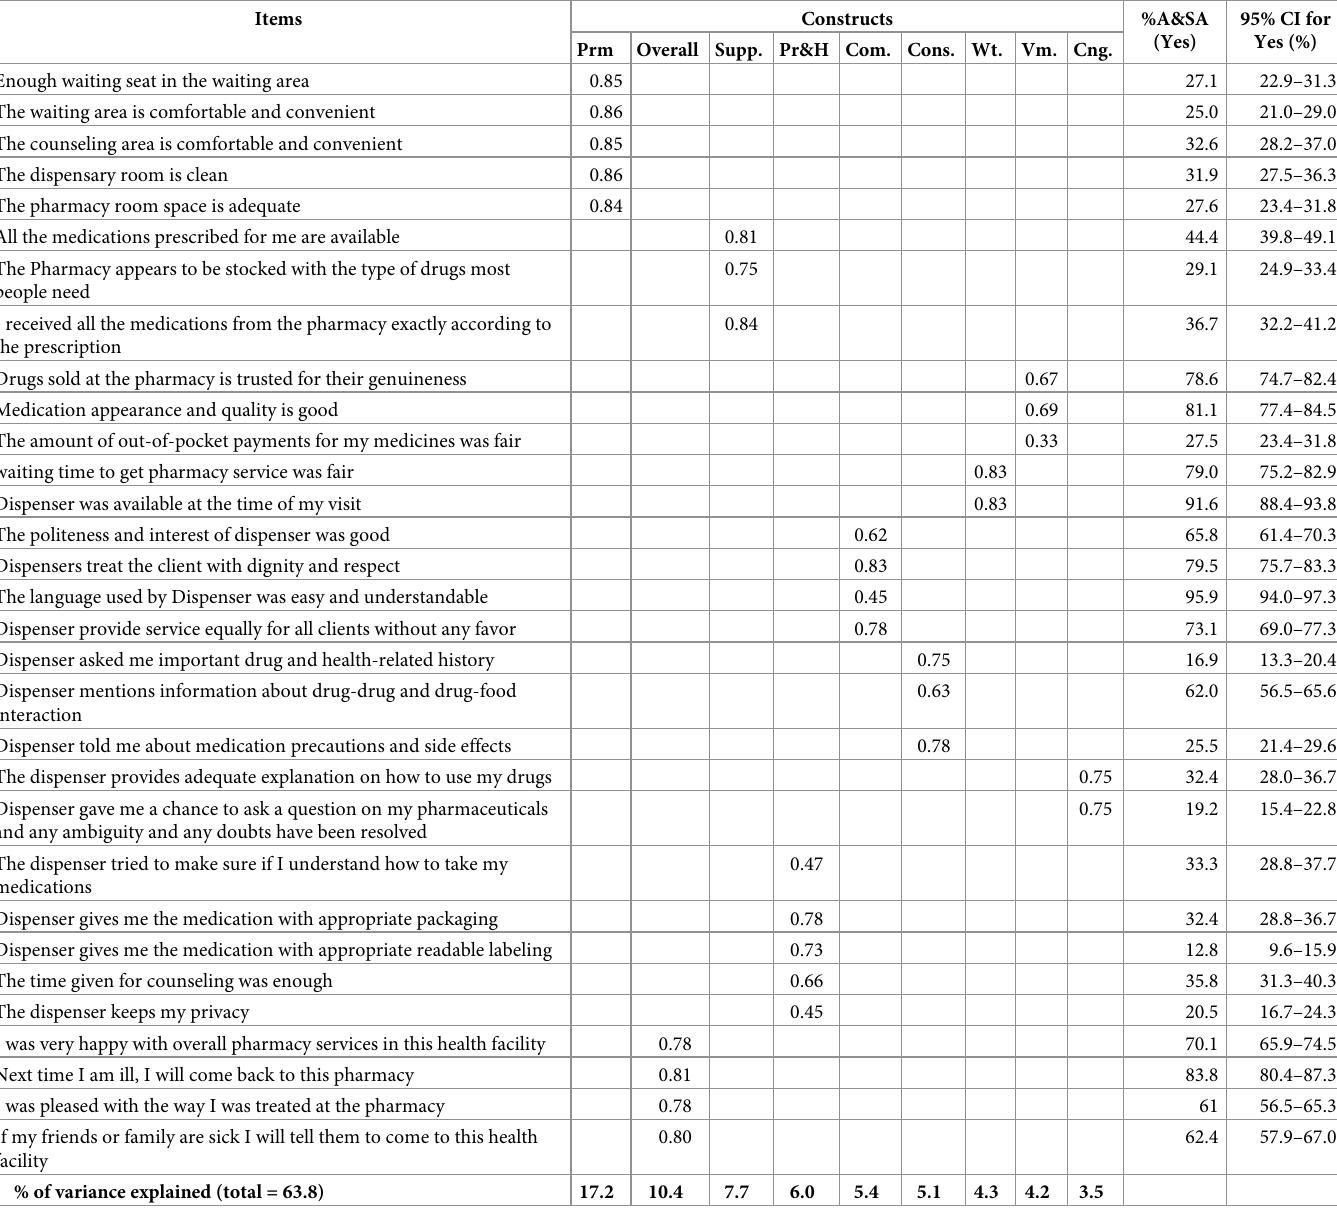
Table 2. Emergent dimensions, factor loading and percentage of agreed and strongly agreed respondents with underlying satisfaction items with pharmacy services, December 2020.